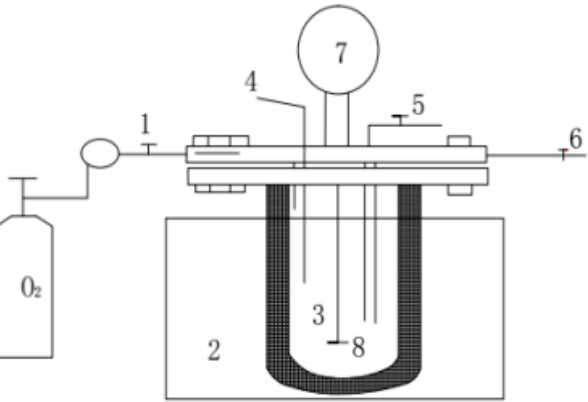
Figure 1. Diagram of wet oxidation reactor.1: Oxygen supply; 2: Heating jacket; 3: Oxidation reactor; 4: Thermocouple; 5: Discharge of gas; 6: Bleeder valve; 7: Pressure meter; 8: Stirrer.